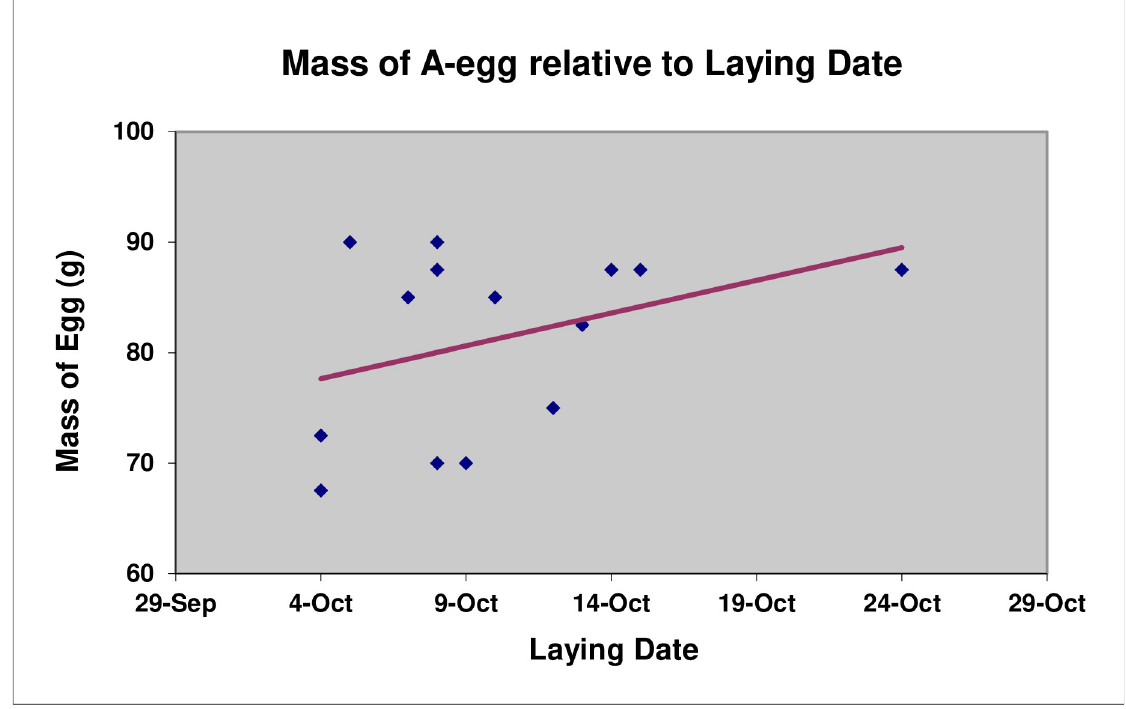
Fig 6. Mass (g) of A-eggs relative to laying date (n =